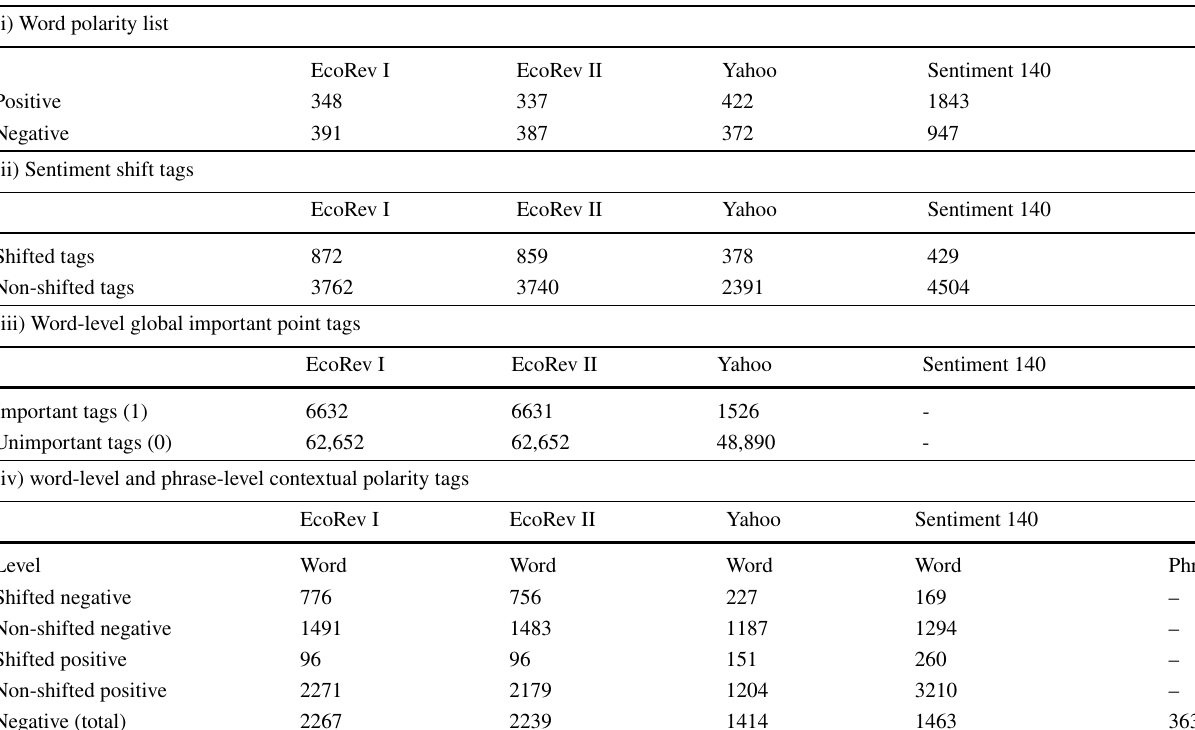
Table 2 Dataset details for text corpus and annotated data (i) Word polarity